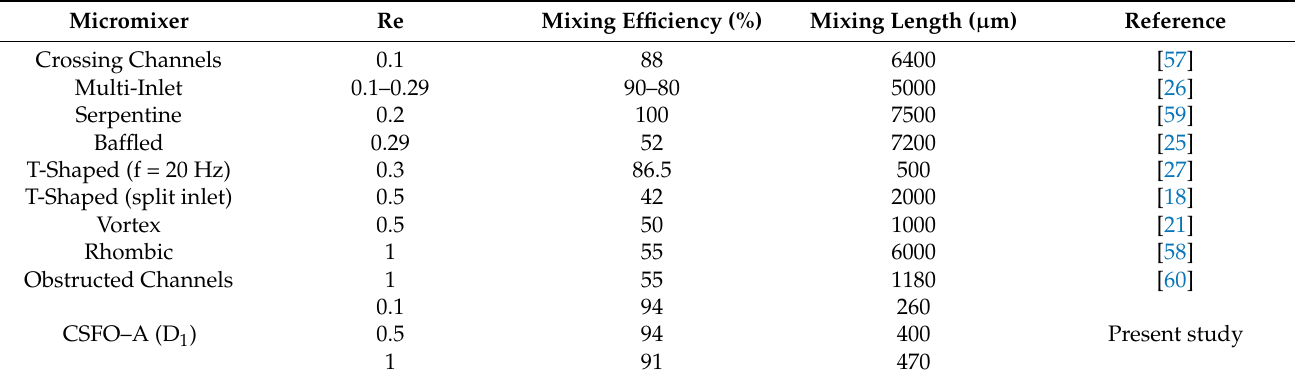
Table 1. The comparison of the CSFO–A configuration with the micromixers reported in the literature in terms of mixing performance in low flow conditions (Re <